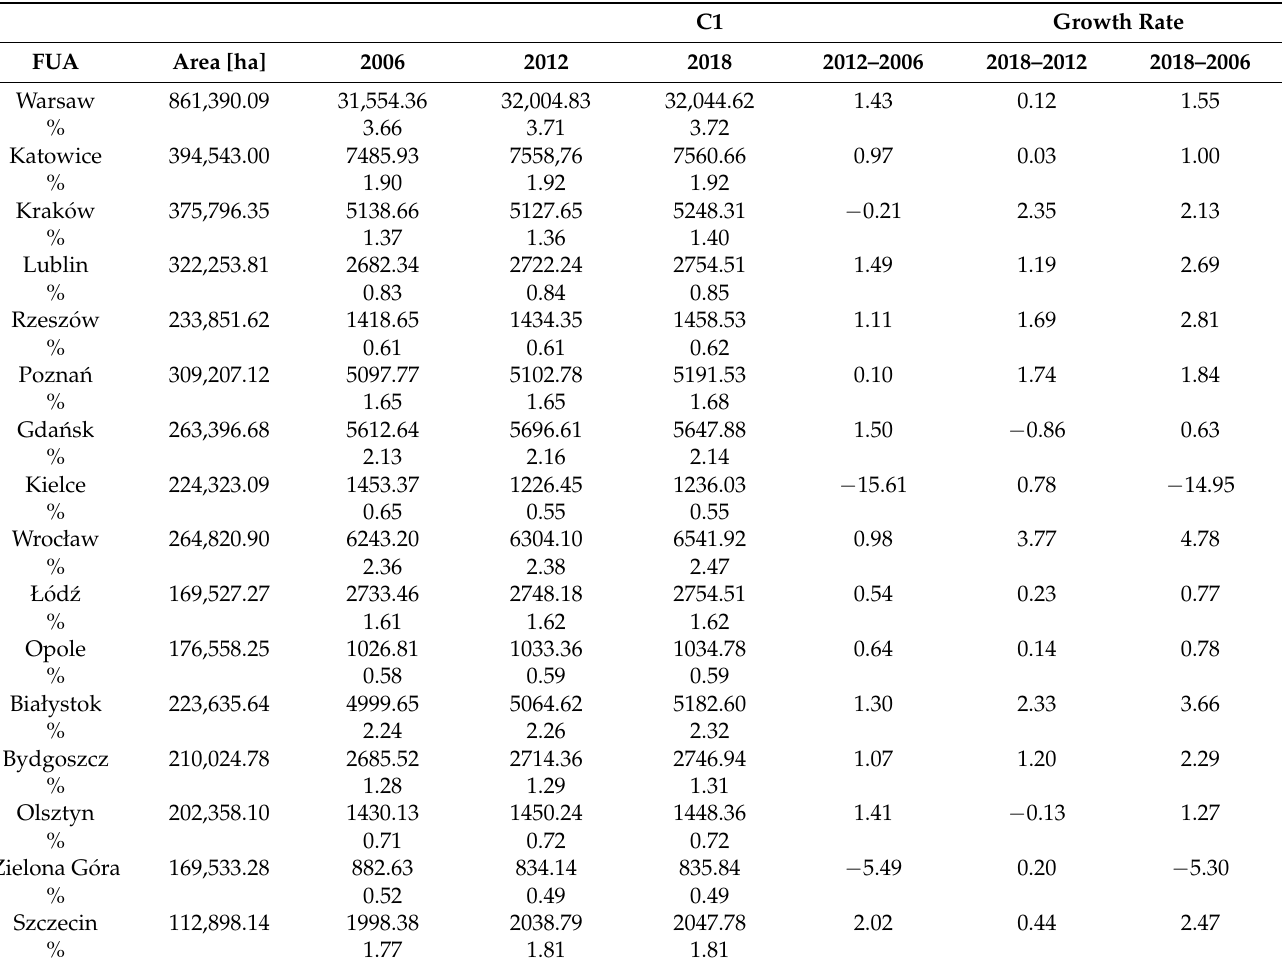
Table 3. C1 area [ha] in each investigated area in 2006, 2012, and